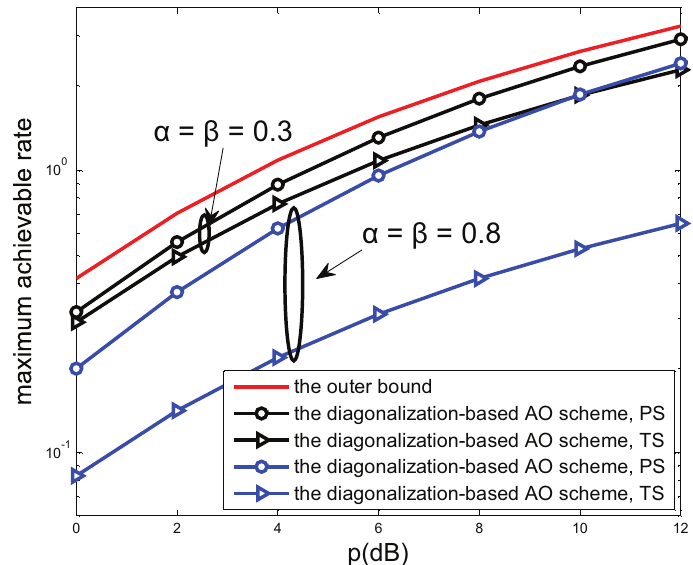
Figure 5. The MAR performance versus p of the proposed schemes for N = 2, L = 4 and α = β ∈ { 0.3,0.8 }